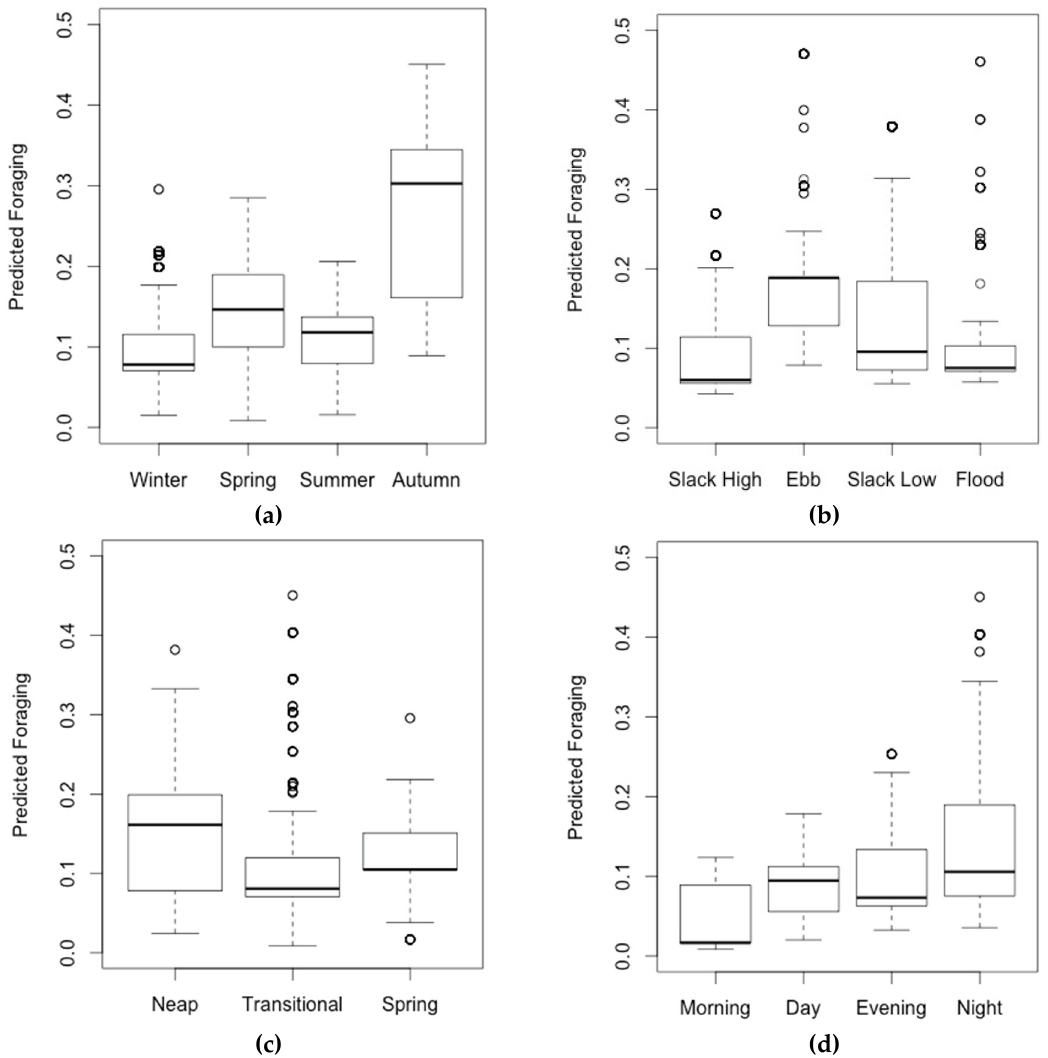
Figure 7. Predicted foraging at Aughinish for the explanatory variables included in the best model: ( a ) Season; ( b ) Tidal Cycle, ( c ) Tidal Phase and ( d ) Diel Phase.